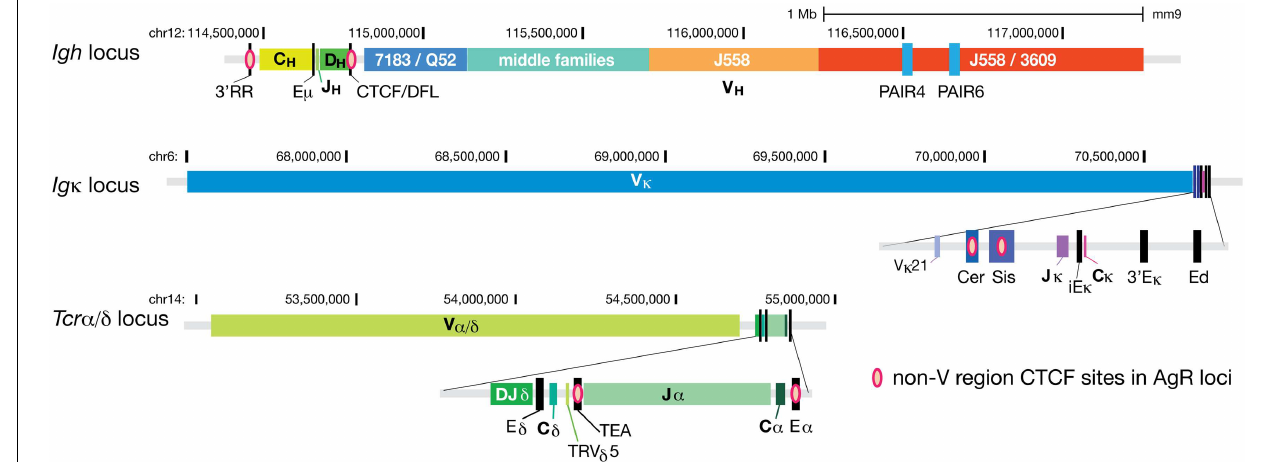
FIGURE 1 | CTCF binds at regulatory elements withinAgR loci . CTCF binding sites at all regions except for theV gene segment part of the loci for the three larger AgR loci; Igh , Ig κ , and Tcr α / δ . Pink ovals represent the non-V region CTCF sites.TheV gene portions of these three AgR loci have